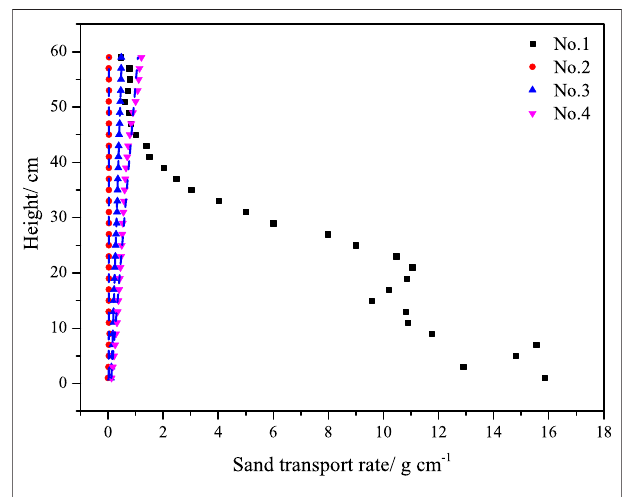
FIGURE 11 | Sand-blocking ef fi ciency of the sand control